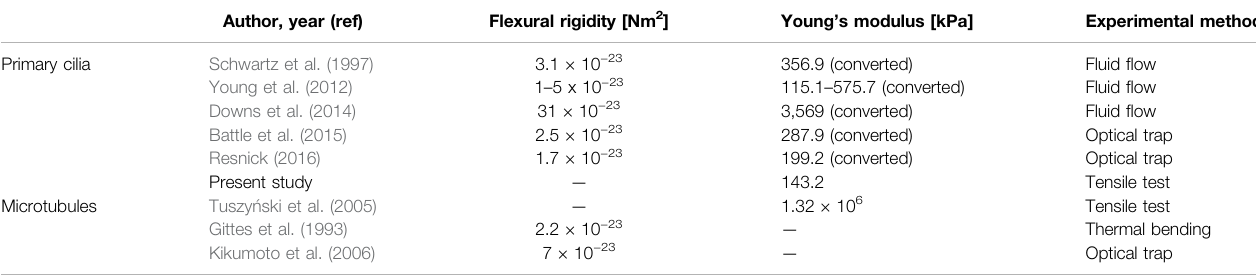
TABLE 2 | Summary of the Young ’ s modulus of primary